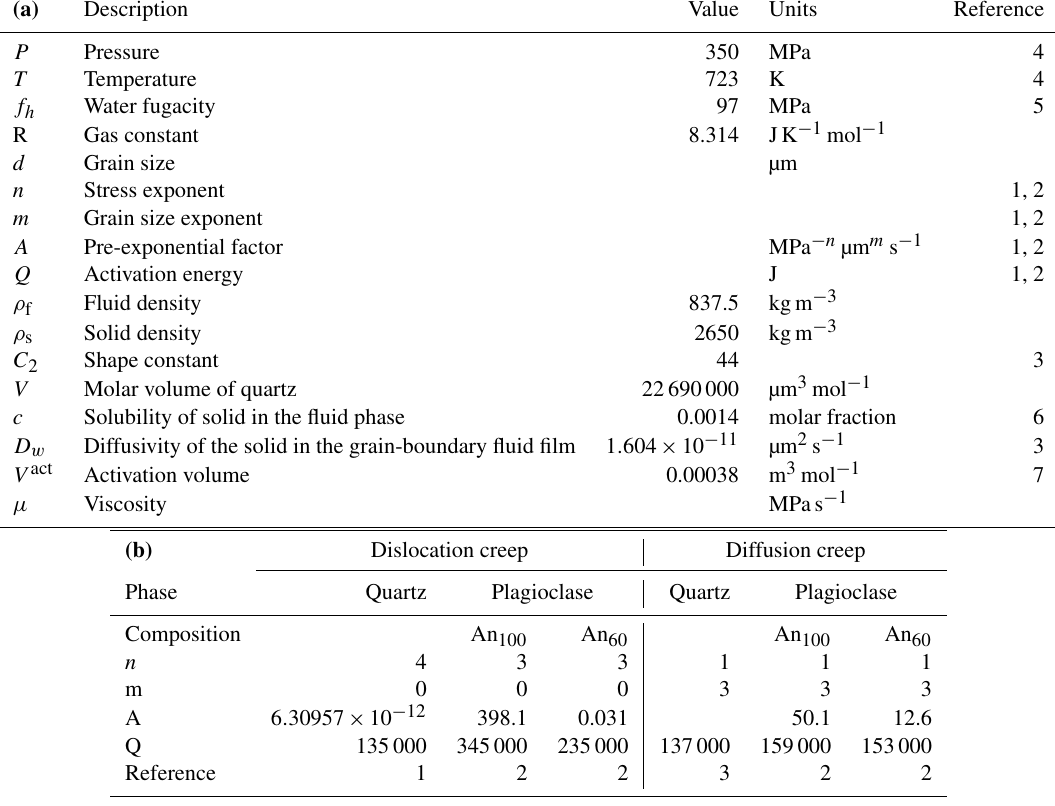
Table 1. Parameters adopted in the rheological calculations. (a) List of the general parameters adopted in the rheological calculations. (b) Values of flow-law parameters adopted in the rheological calculations according to mineral phase and deformation mechanism.